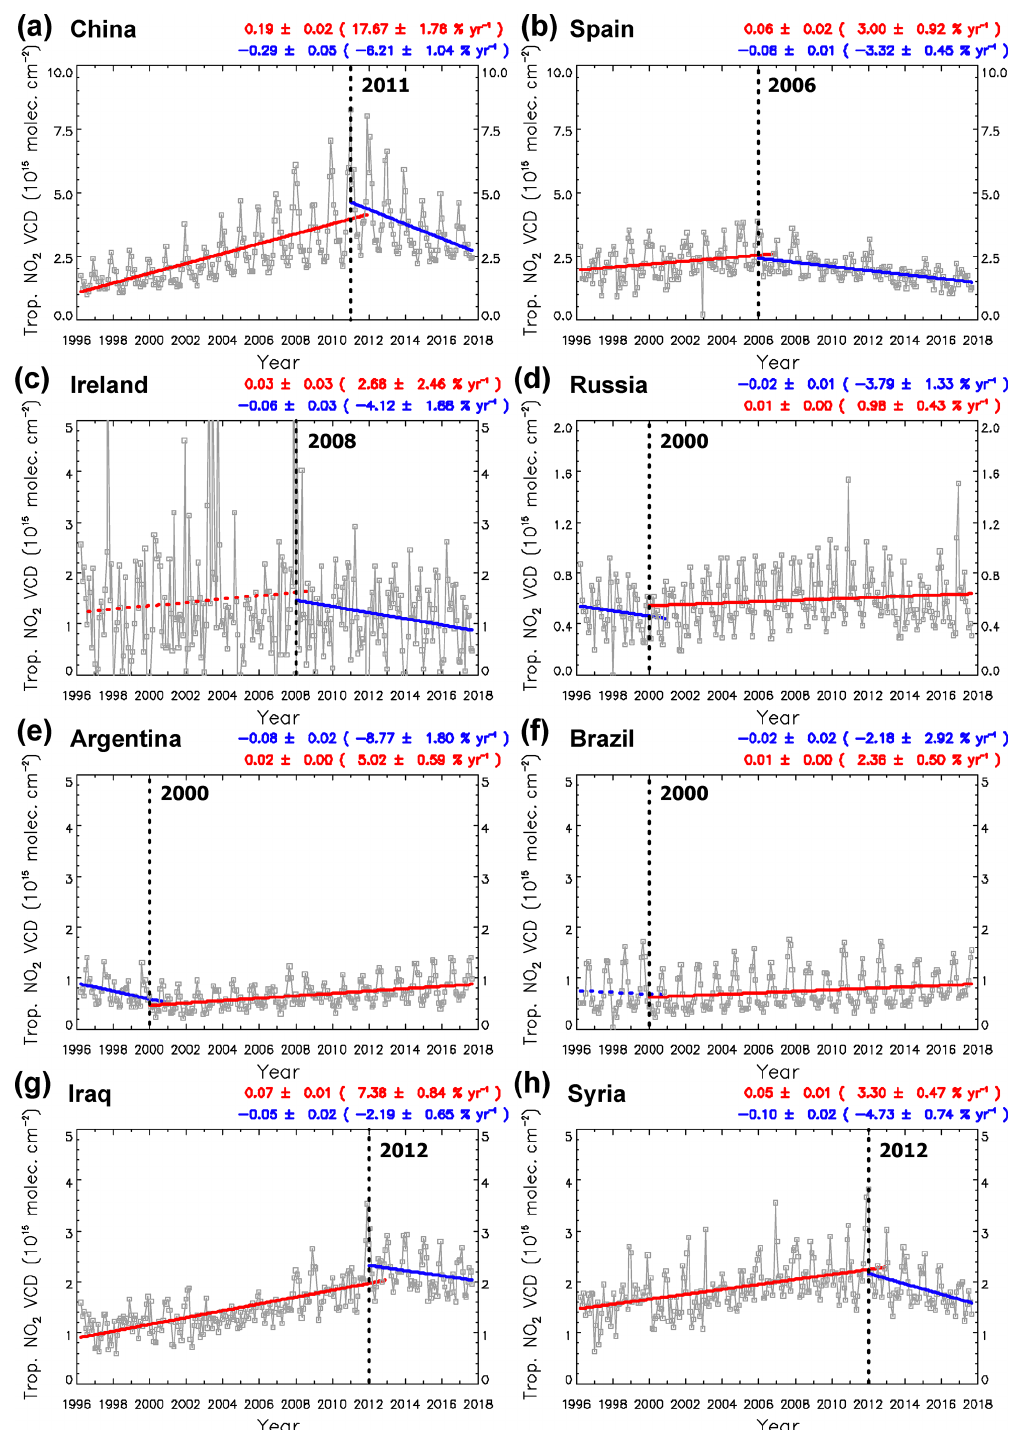
Figure 8. Satellite-based time series (grey points and lines) of tropospheric NO 2 VCD for the period April 1996–September 2017 for China (a) , Spain (b) , Ireland (c) , Russia (d) , Argentina (e) , Brazil (f) , Iraq (g) , and Syria (h) . The thick lines depict the trend (solid for statistically significant trends and dashed for statistically insignificant trends at the 95% confidence level; red color for positive trends and blue color for negative trends) for the sub-period before and the sub-period after the detected trend reversal (the year of reversal is included in both sub-periods). The year of the trend reversal is indicated with a thick black dotted line. The absolute trends (in 10 15 moleculescm − 2 yr − 1 ) and the trends (in %yr − 1 ) relative to the fitted mean of the first year of the sub-periods (in parentheses) with the corresponding uncertainties ( ± 1 σ ) are given on the plots (upper and lower lines correspond to the fist and the second sub-period,